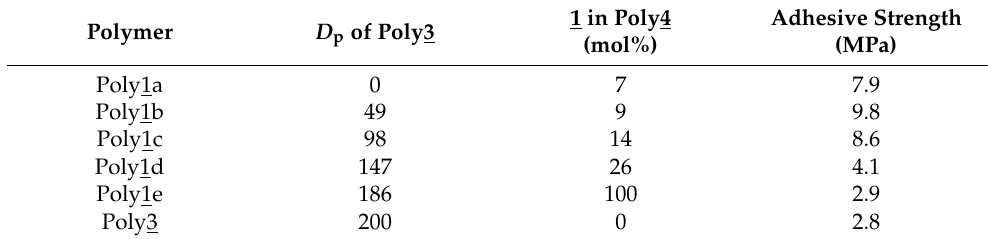
Table 2. Adhesive Strength of the Gallic-Acid-Bearing Polymers.